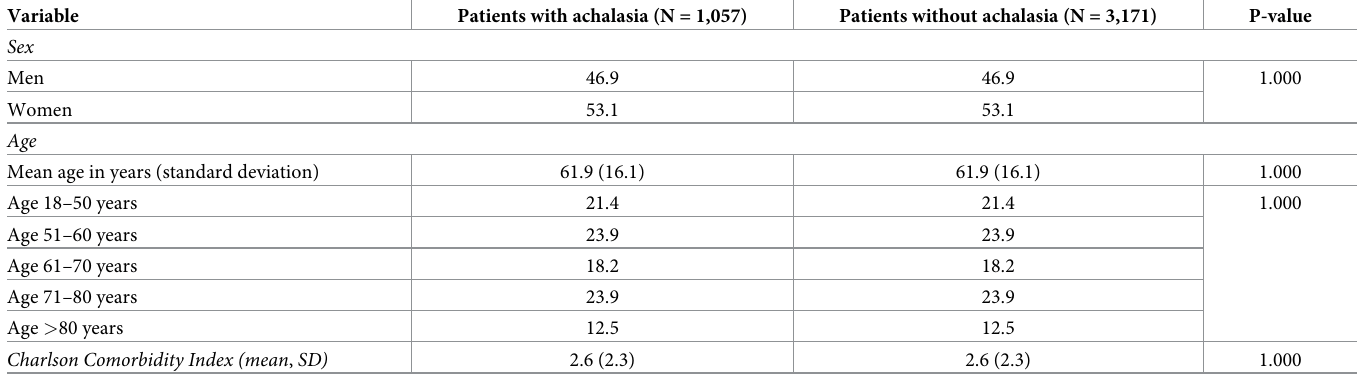
Table 1. Baseline characteristics of study patients after 1:3 matching.